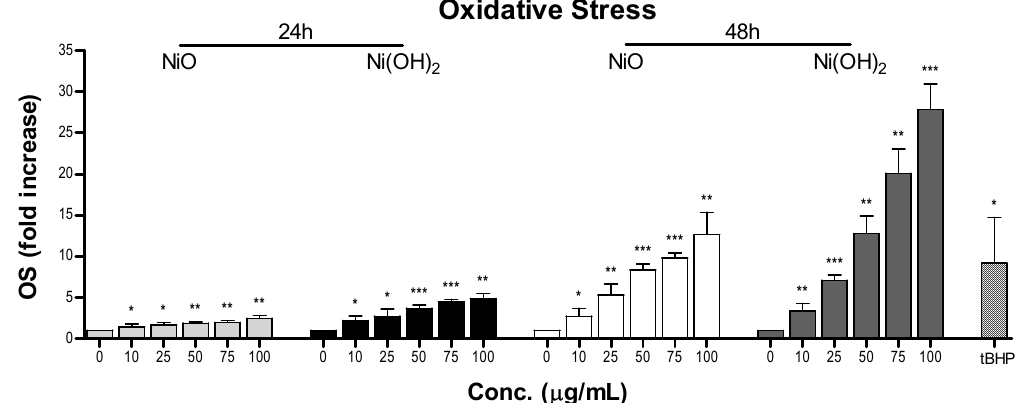
Figure 5. Reactive oxygen species (ROS) produced in A549 cells upon exposure to various concentrations of NiO or Ni(OH) 2 for 24 and 48 h. Untreated cells were considered 1-fold of activity and treated cells were the relative fold increase in ROS. Tert-butyl hydroperoxide (tBHP) served as a positive control, * p < 0.05, ** p < 0.01, *** p < 0.001 vs. control using a one-tailed, unpaired t -test. Values are expressed as the mean ± SD from four independent experiments.